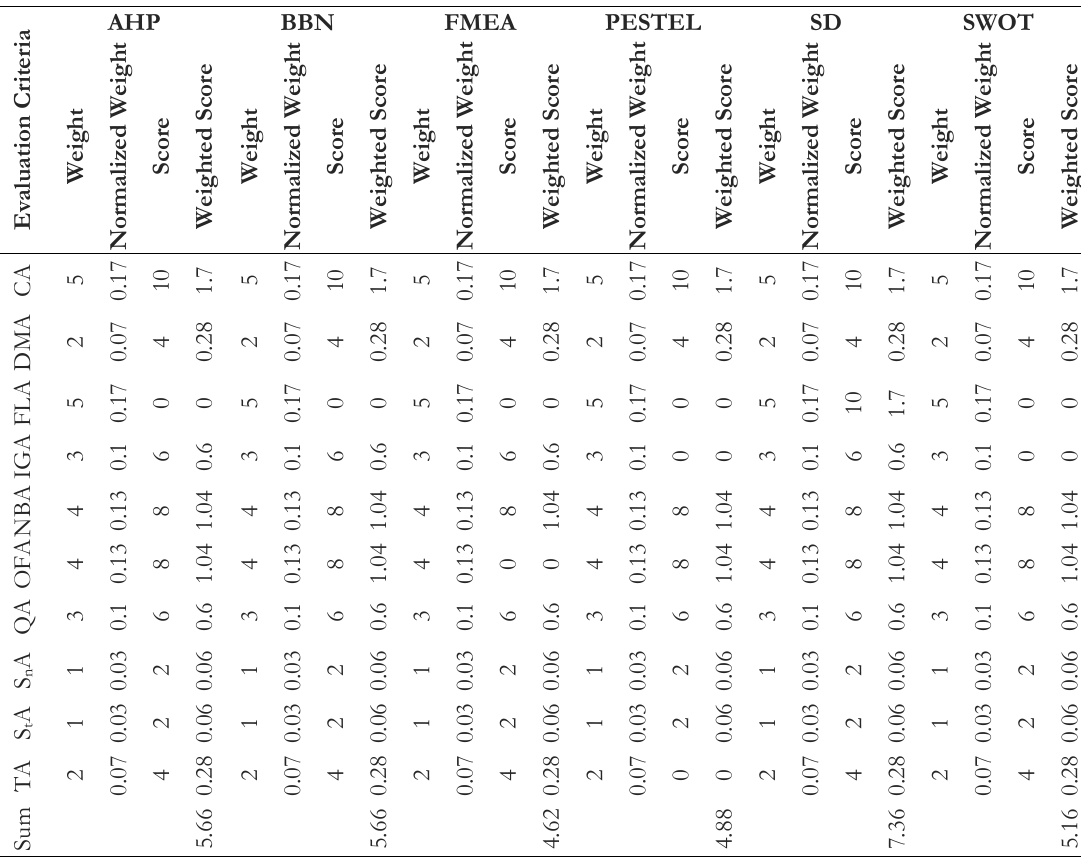
Table 2. Trade-off analysis matrix for methodology